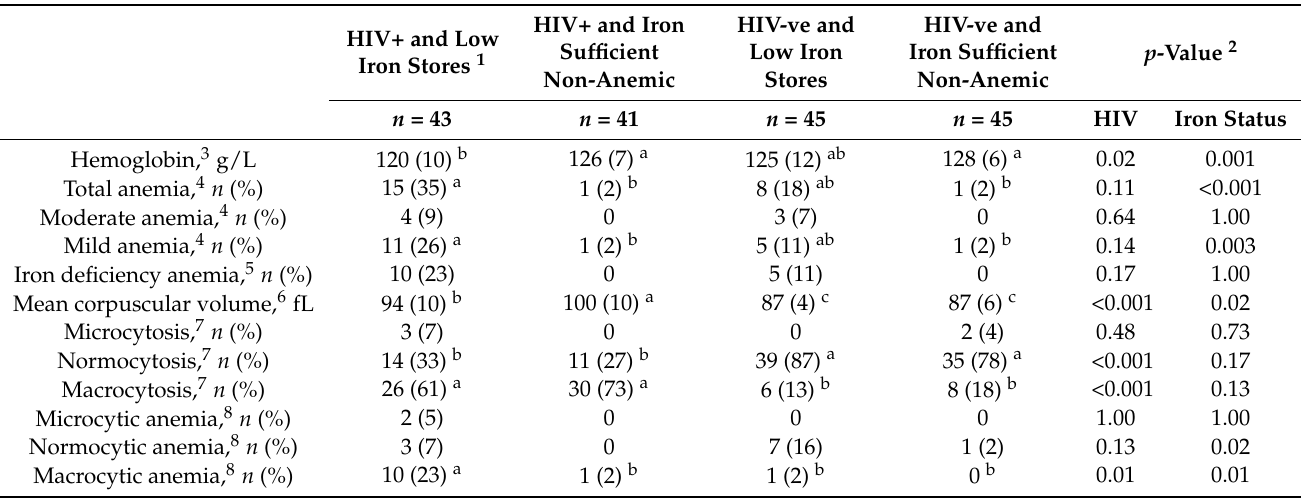
Table 4. Hematological indices in the four groups of South African children purposefully selected according to HIV and iron